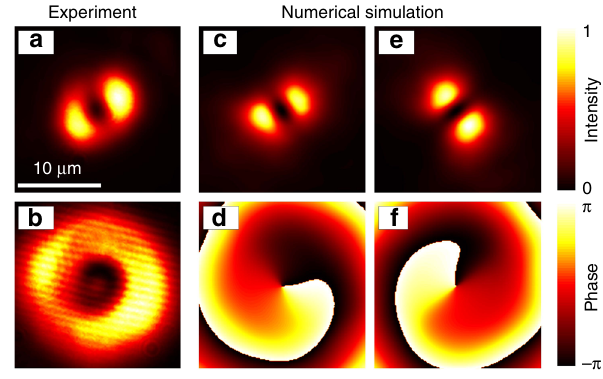
Fig. 5 Vortices in experiment and numerical simulation. a Real-space representation of normalized measured condensate photoluminescence as observed in Fig. 3 before application of the control pulse at negative times. b Normalized ring-shaped optical excitation intensity pro fi le used in experiment. c – f Computed normalized condensate density and corresponding phase pro fi les in vortex states before ( c , d ) and after ( e , f ) switching including sample